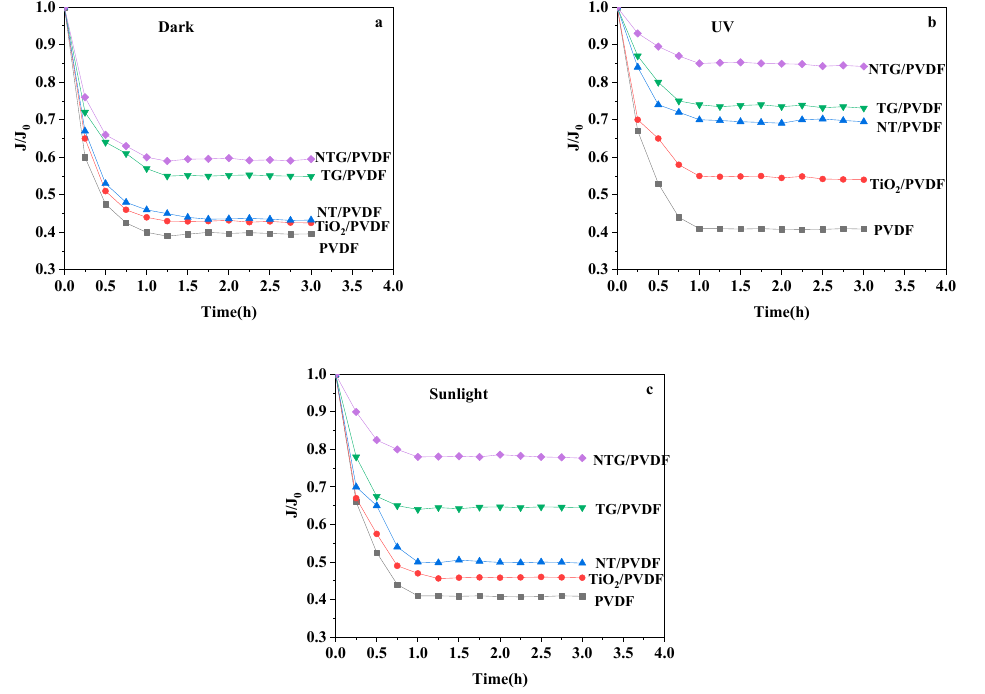
Figure 8. The relative flux of the methylene blue (MB) solution ( a ) in the dark; ( b ) ultraviolet and ( c ) sunlight conditions.